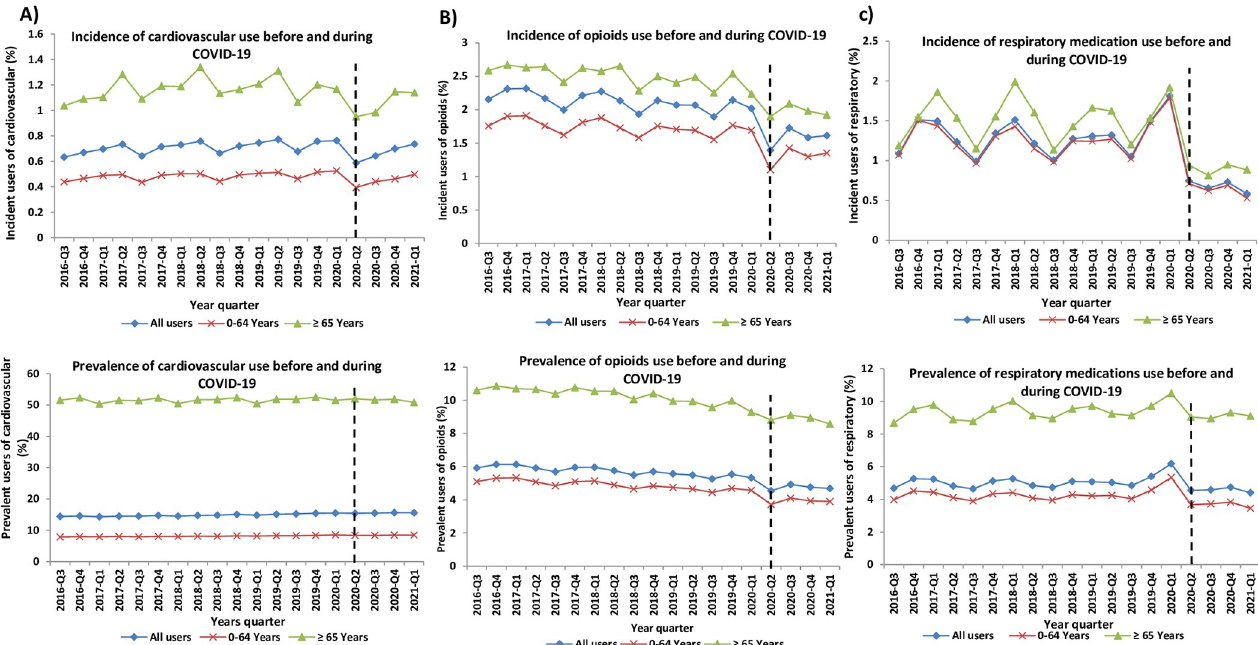
Fig 2. Incidence and Prevalence of (A) Cardiovascular, (B) Opioids and (C) respiratory medications use stratified by age in Manitoba from Q3-2016 until Q1- 2021.